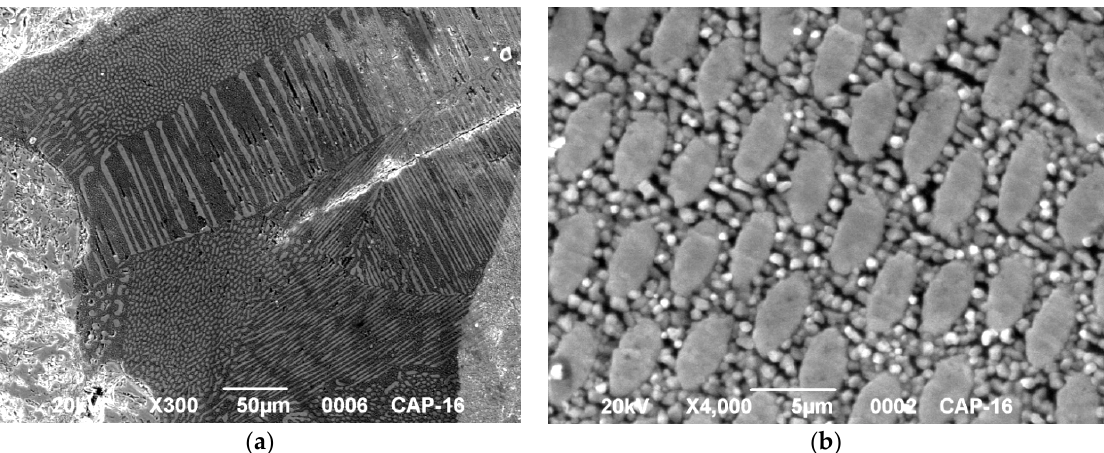
Figure 4. SEM images of crystallites at the transverse cut: ( a ) ×300 magnification; ( b ) ×4000 magnification.